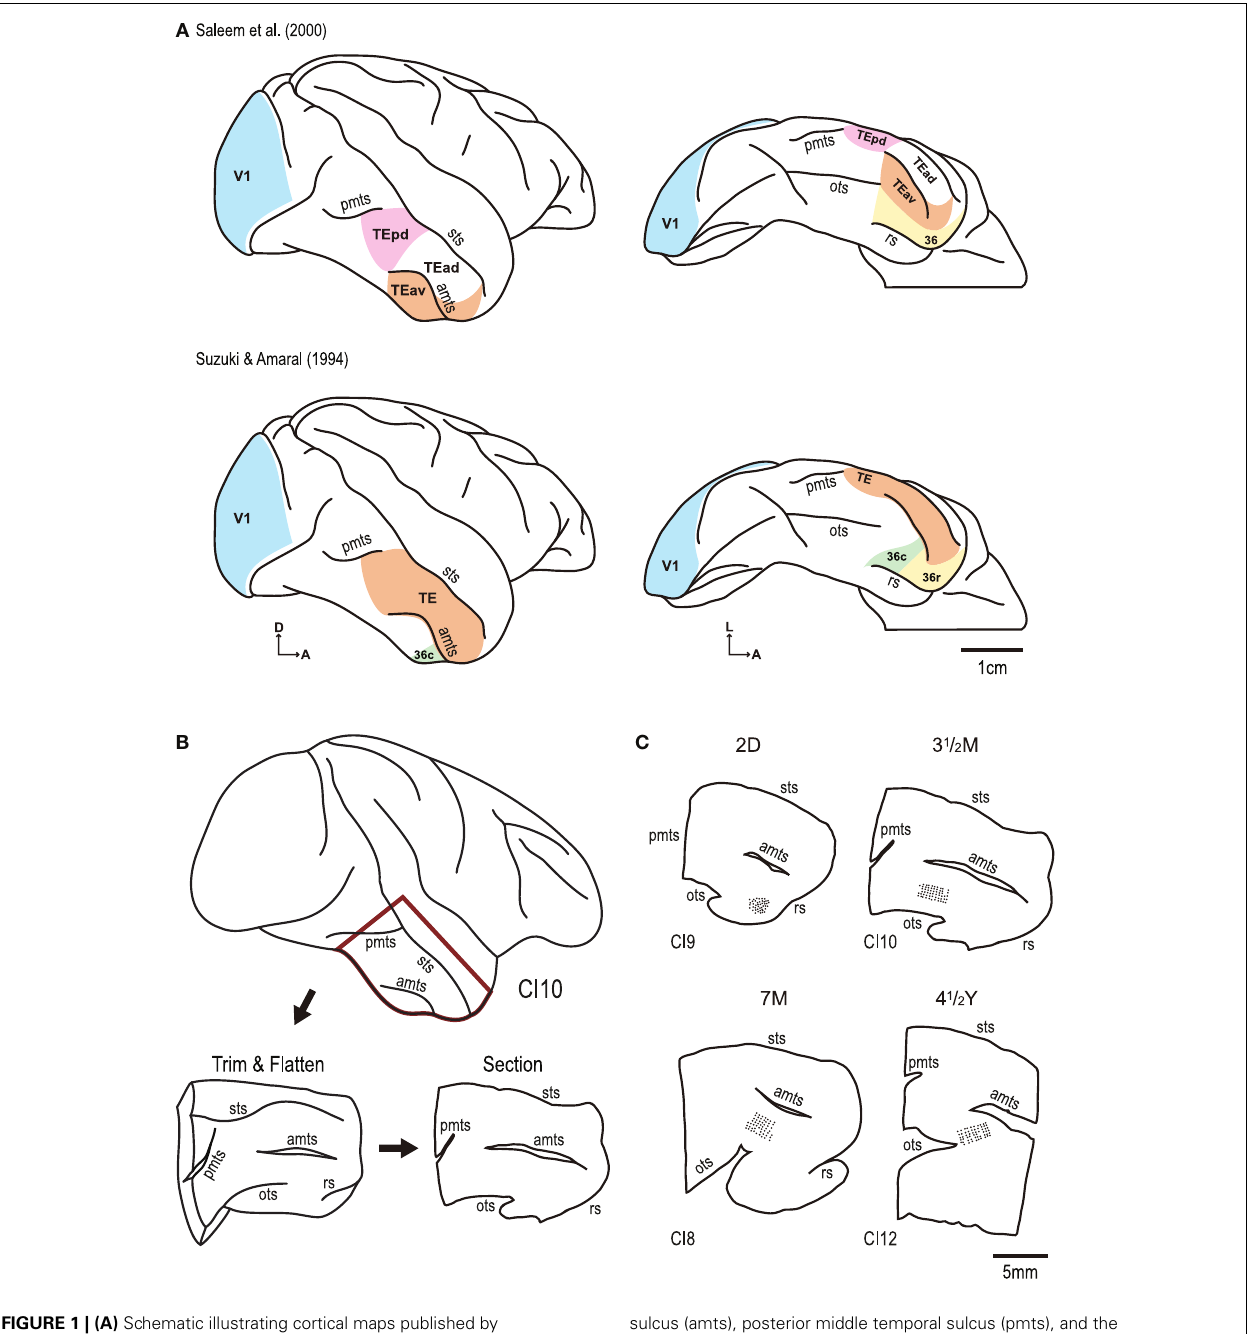
FIGURE 1 | (A) Schematic illustrating cortical maps published by Saleem et al. (2000) and Suzuki and Amaral (1994). Note, in particular, differences in the location of the borders of areasTE and 36. Note also that areaTE has been subdivided by Saleem and colleagues to include a posterior and anterior region (TEp andTEa, respectively), and that the anterior region has been divided into dorsal and ventral regions (TEad andTEav, respectively). (B) Slice preparations for intracellular injection were prepared by opening up the anterior middle temporal